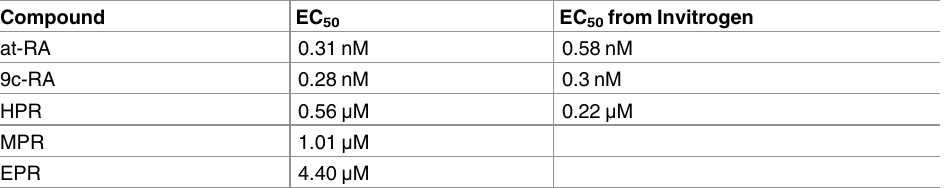
Table 1. EC50 value comparison.